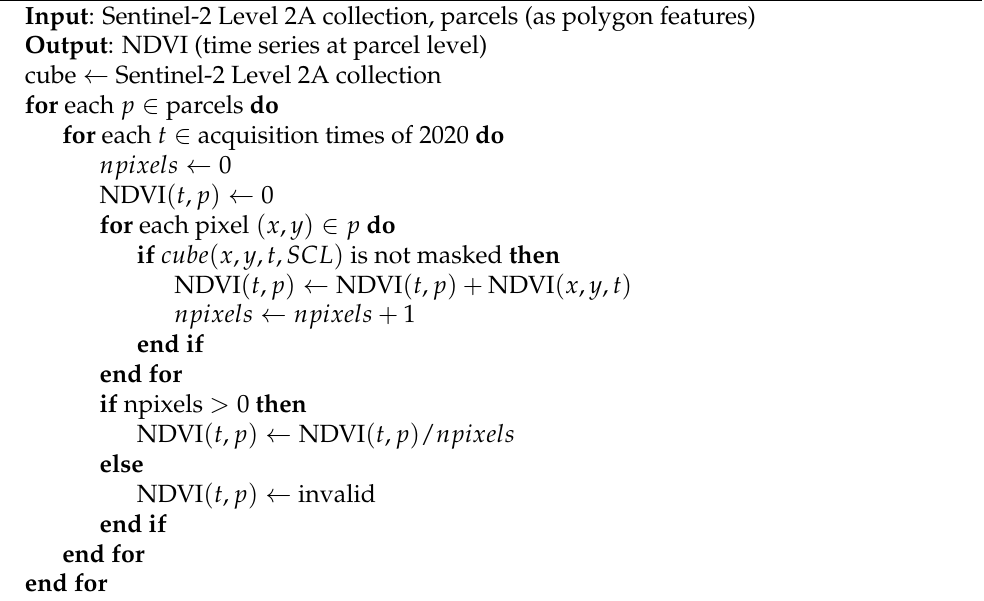
Algorithm 1 Pseudocode to obtain spatially aggregated normalized difference vegetation index (NDVI) time series at the parcel level.